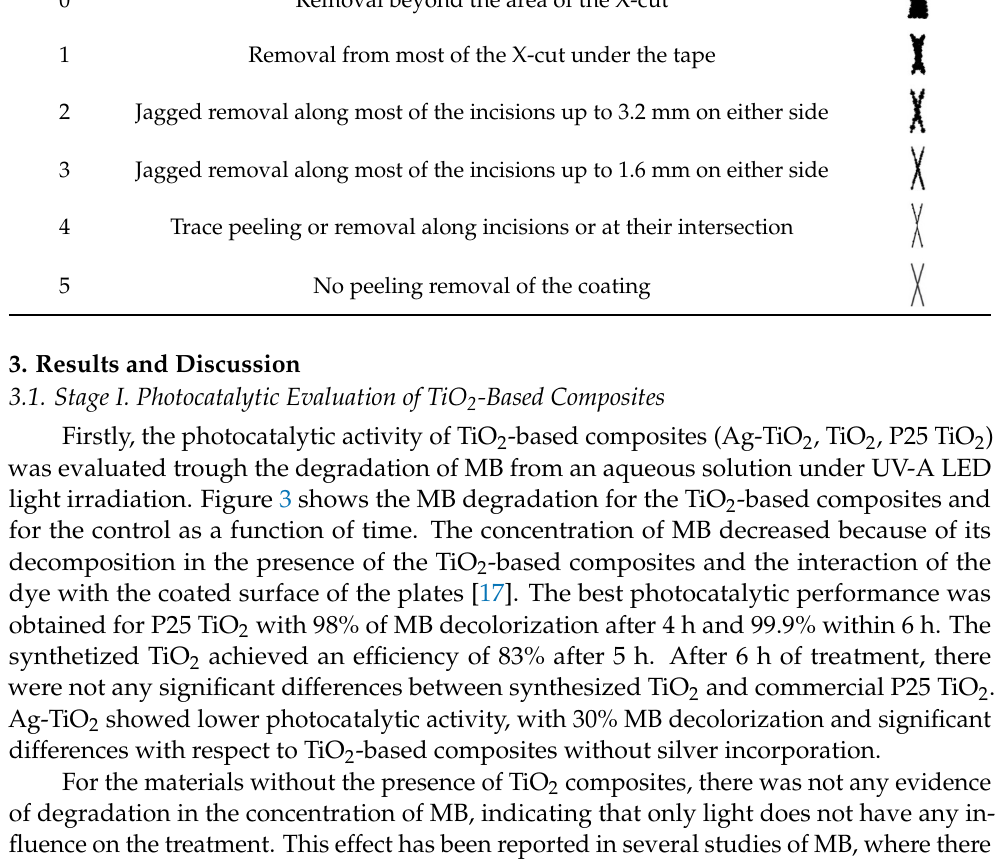
2 Jagged removal along most of the incisions up to 3.2 mm on either side